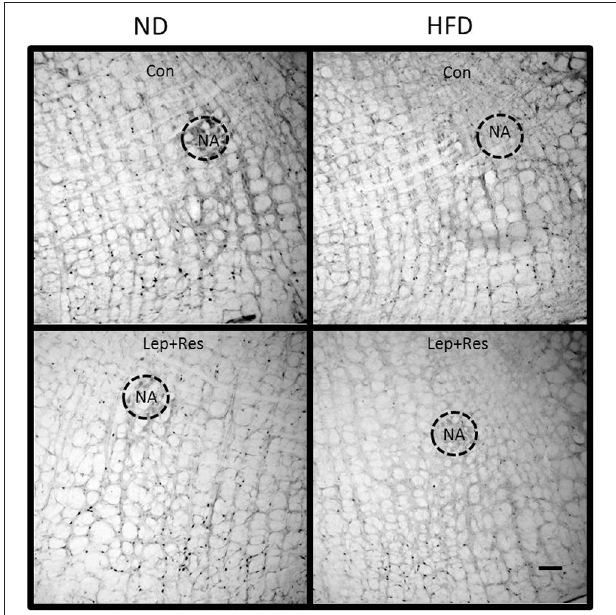
FIGURE 16 | Photomicrographs showing Fos-positive cell nuclei in the rostral ventrolateral medulla of rats fed a high fat diet (HFD) and rats fed a normal diet (ND) following centrally administered saline (5 µ l; control) or leptin combined with resistin (7 µ g). NA, nucleus ambiguus. Scale bar = 100 µ m. The rostrocaudal levels of the sections counted were at ∼ 12.2–12.4mm caudal of bregma.